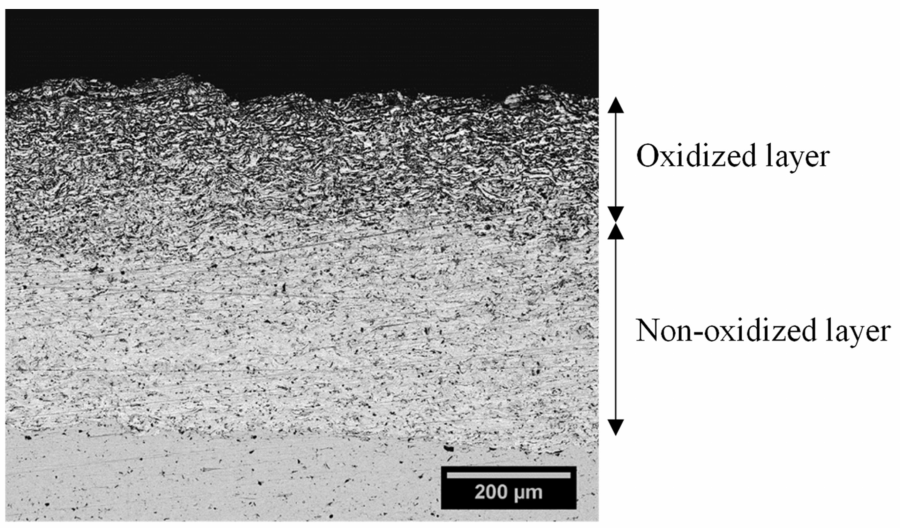
Figure 14. Cross-section SEM image of a Zn-15wt.%Al coating immersed 3 days in “solution 15” at 80 ◦